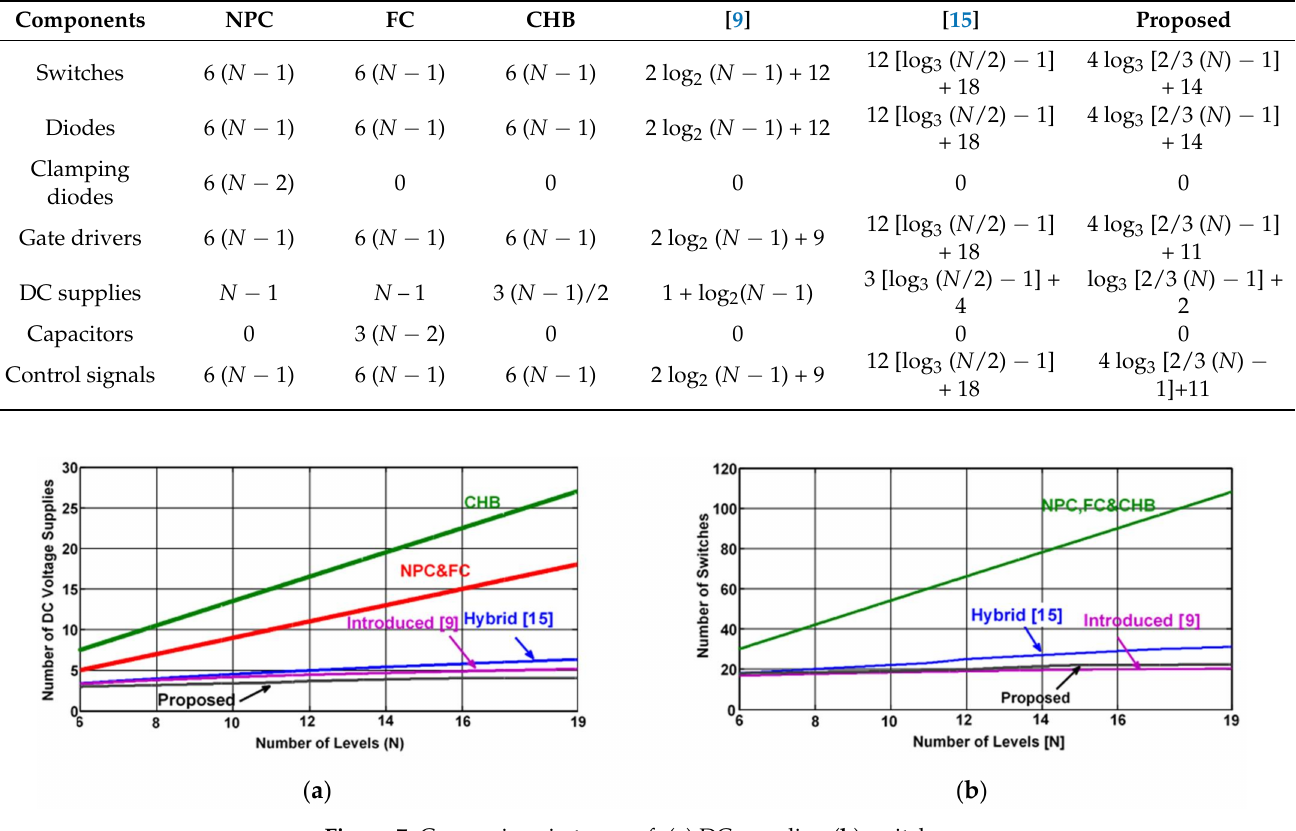
Figure 7. Comparison in terms of: ( a ) DC supplies, ( b ) switches. Table 4. Voltage ratings of proposed topology switches.